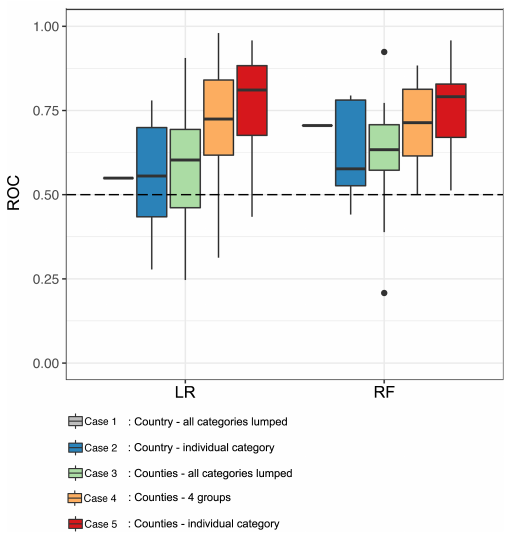
Figure 3. Model performance for the five cases using logistic re- gression (LR) and random forest (RF) approaches to predict drought impacts for the period 2016–2017. The boxes indicate the spread of ROC values for drought impact functions (15 ensemble members). The black dashed line indicates the threshold (ROC = 0.5). All val- ues below this line show that the models have no discriminative capacity to distinguish impact and no impact. The dots stand for model